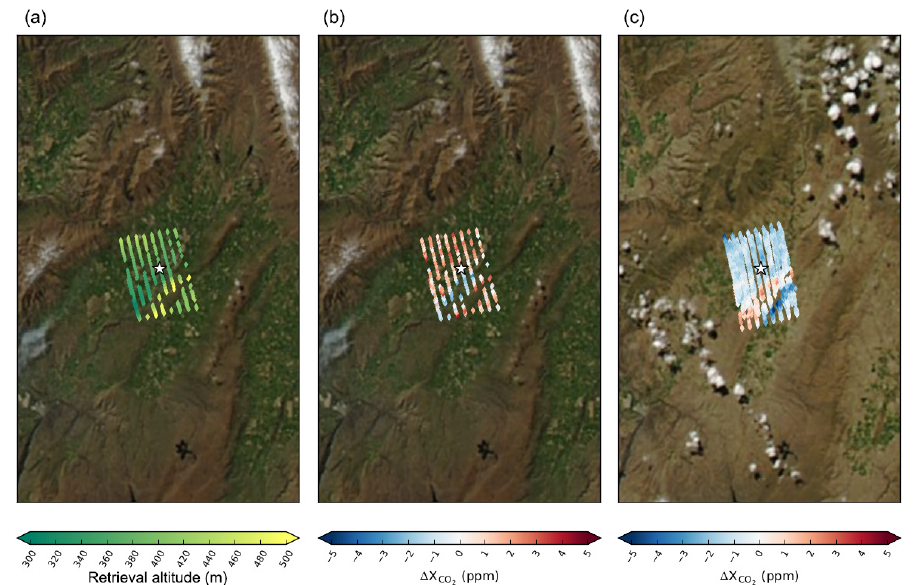
Figure 10. Data from OCO-2 targets over the Lauder TCCON station. The background is the MODIS true-color image of the Lauder area at the time of the target-mode maneuvers. The white star indicates the location of the Lauder TCCON station. The left panel shows the elevation model of the surface. The middle panel shows the difference in X CO from the value recorded by the TCCON instrument on 2 27 September 2014. The right panel shows the difference in X CO from the value recorded by the TCCON instrument on 17 February 2015. 2 A spatial bias is clearly present, related to the surface elevation, but the sign of the bias changes between targets prior to 20 November 2014 and